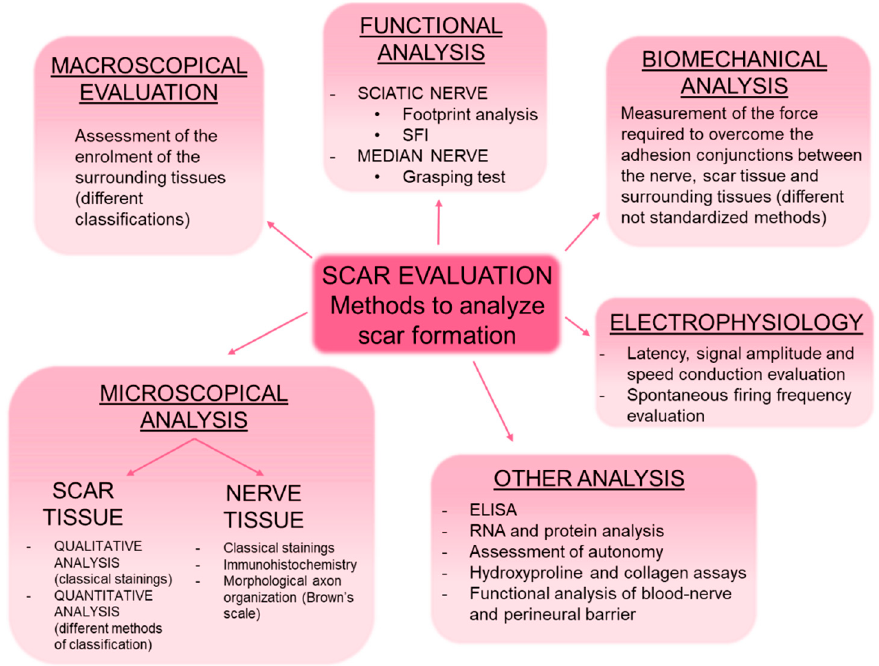
Figure 2. Representative scheme showing the different methods of evaluating scar formation in preclinical models. SFI (sciatic functional index), ELISA (enzyme-linked immunosorbent assay).